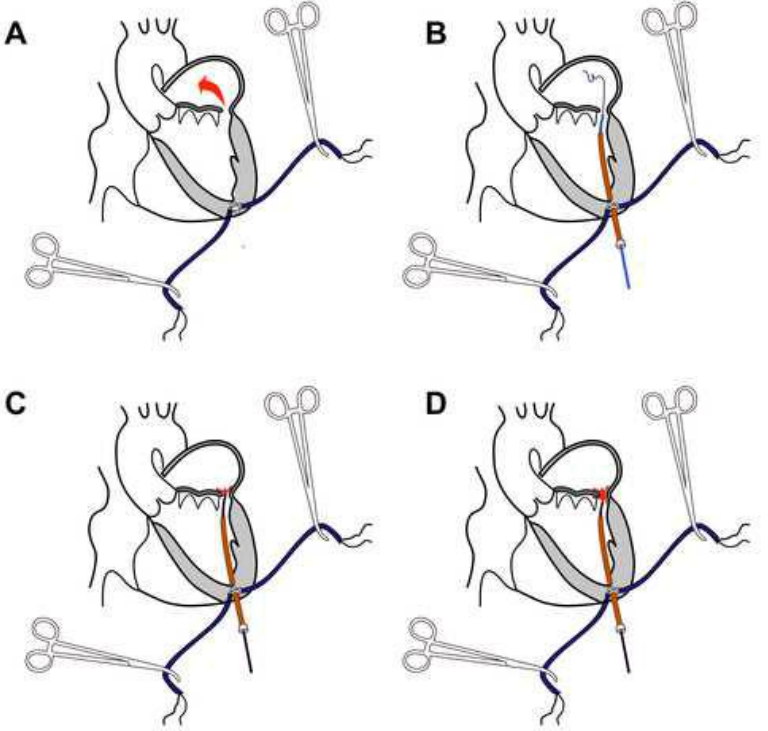
Figure 1. Transapical catheter-based mitral PVL closure procedure: ( A ) “U” shape sutures secured with the tourniquets; the red arrow shows the blood-flow through the defect; ( B ) hydrophilic guidewire passed through the defect; ( C ) release of the distal (atrial) disc of the device; ( D ) release of the proximal (ventricular) disc of the